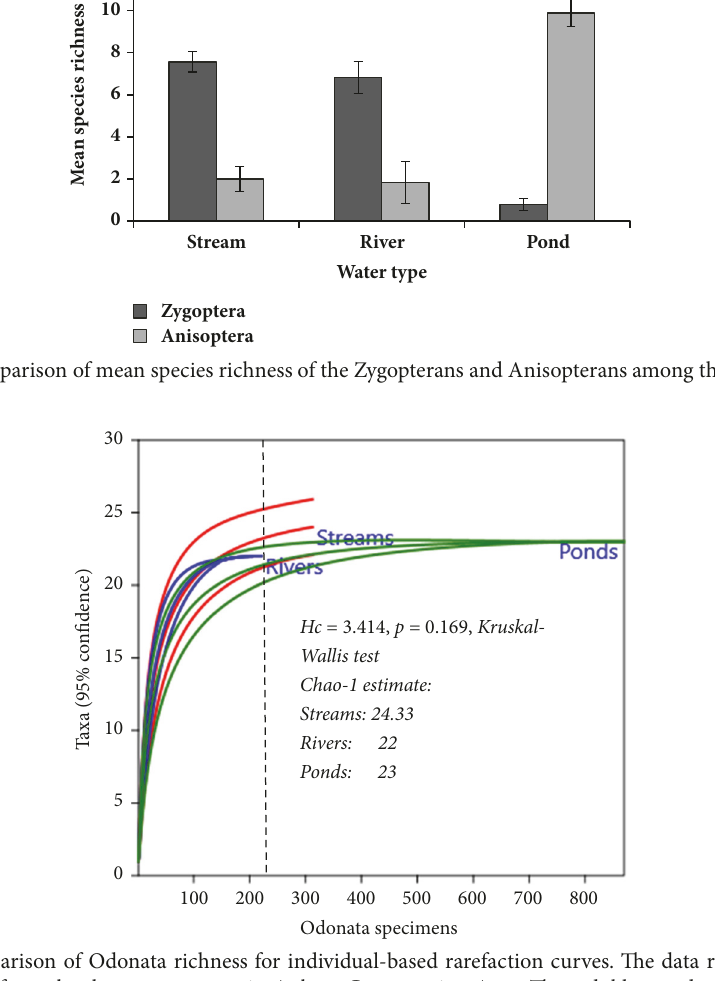
Figure 6: Standardized comparison of Odonata richness for individual-based rarefaction curves. The data represent summary counts of Odonates that were recorded from the three water types in Ankasa Conservation Area. The red, blue, and green lines are the rarefaction curves,calculatedfrom (2) [24], with a 95% confidenceinterval.The dotted verticallines illustratea species richnesscomparison standardized to 24 species and 221 individuals, which was the observed Odonate abundance in the smallest (rivers) of the three water types data